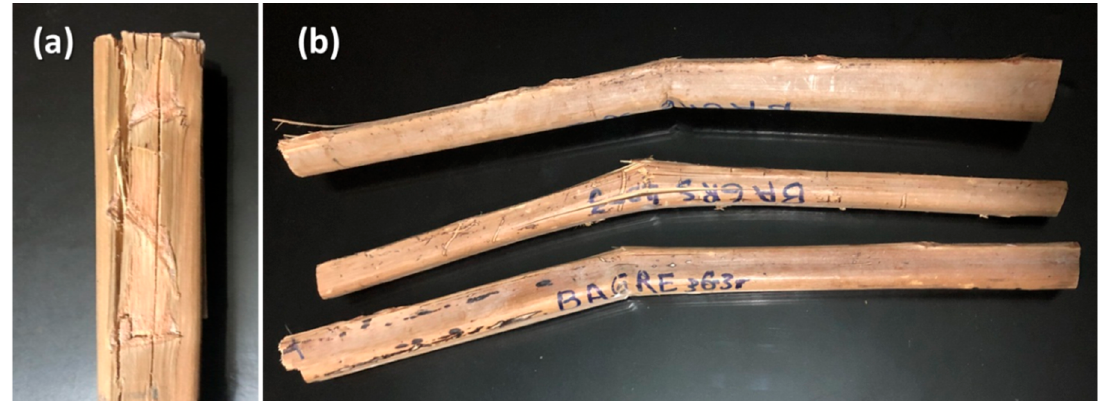
Figure 21. Failure patterns of date palm midribs. ( a ) The longitudinal cracks in date palm midribs in tension testing. ( b ) The breaking failure in date palm midribs in bending testing.